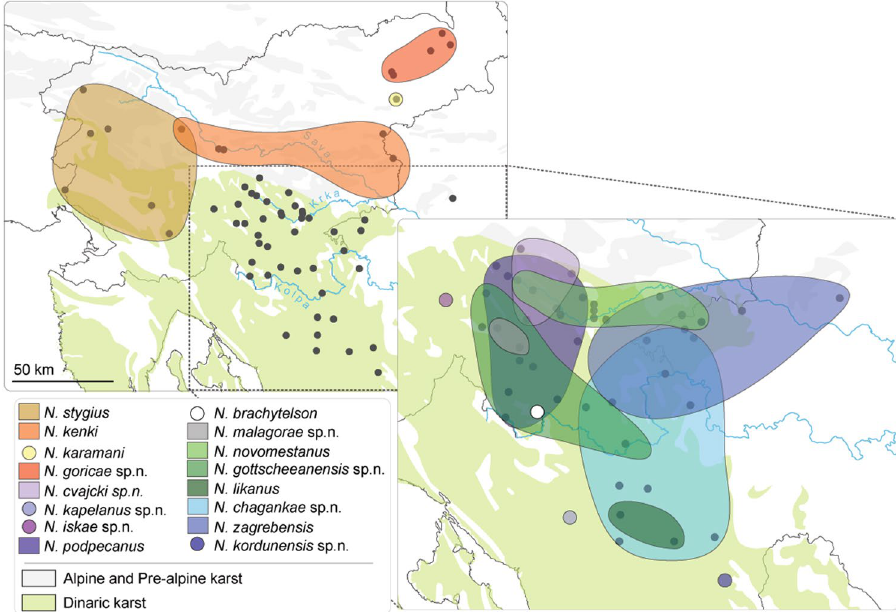
Figure 1. Distribution of species of the Niphargus stygius complex. Sampling sites are represented as dots with overlaid approximate ranges based on known sites. Sampling localities were GPS georeferenced and a basic layout was produced in ArcGis 10.1 (http://www.esri.com/software/arcgis/arcgis-for-desktop), the exported image was then edited in Adobe Illustrator CS6 (http://www.adobe.com/support/downloads/product. jsp?platform = Windows&product =